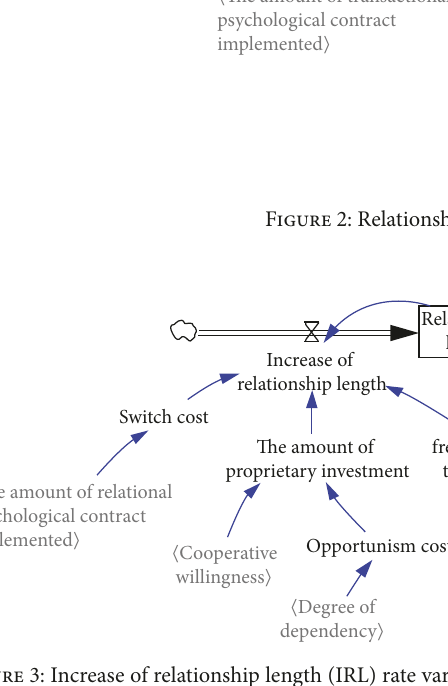
Figure 3: Increase of relationship length (IRL) rate variable in-tree branch.